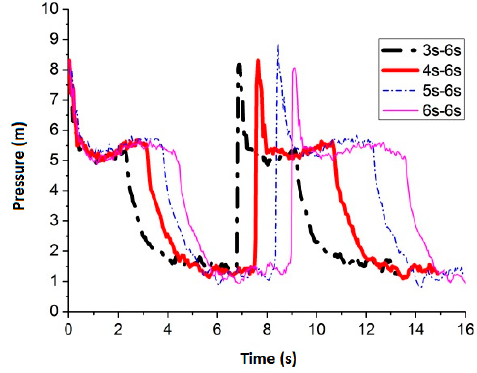
Figure 7. The four best pressure values (round nozzle on top of the pipe).